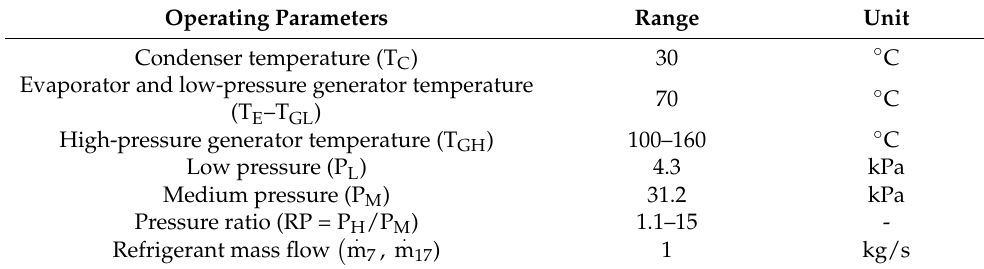
Table 1. Operating conditions of the MAHP.